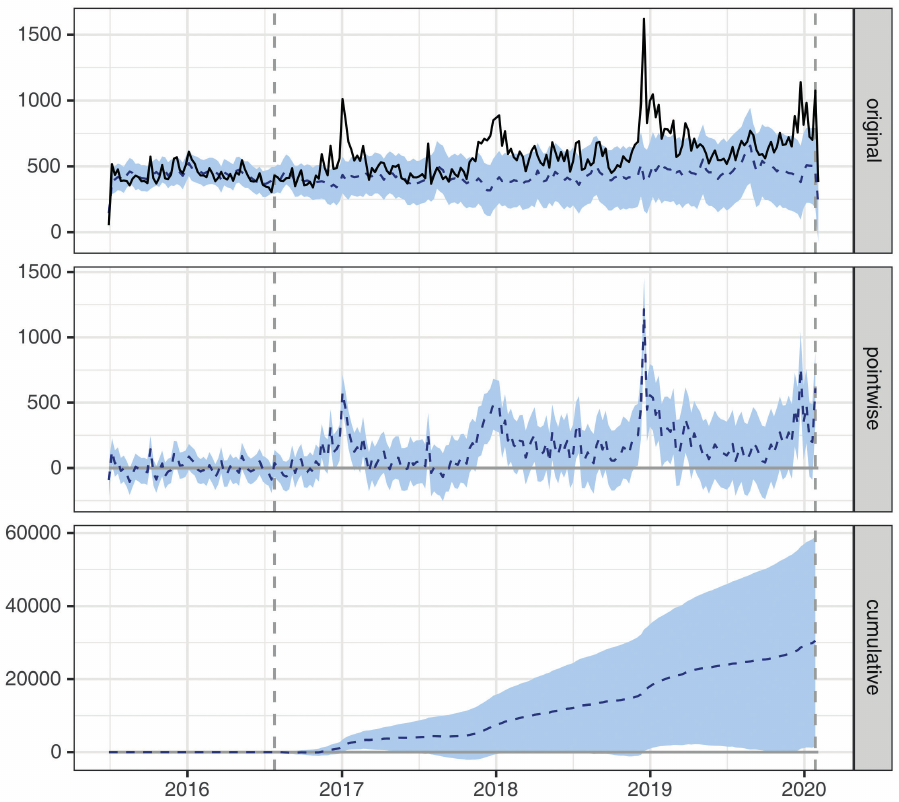
Figure 3. Causal impact of the first Union list on visits to Wikipedia pages about invasive alien mammals that were not included in the list. Upper plot: visits to pages of invasive mammals not in the list (solid line) versus the counterfactual, obtained from the visits to pages of native mammals (dashed line and high- lighted area). Middle plot: estimated causal effect, expressed as the difference between treated and control time series. The causal effect was significant if its 95% credibility interval did not include zero. Lower plot: cumulative causal effect in time, significant only when the 95% credibility interval did not include